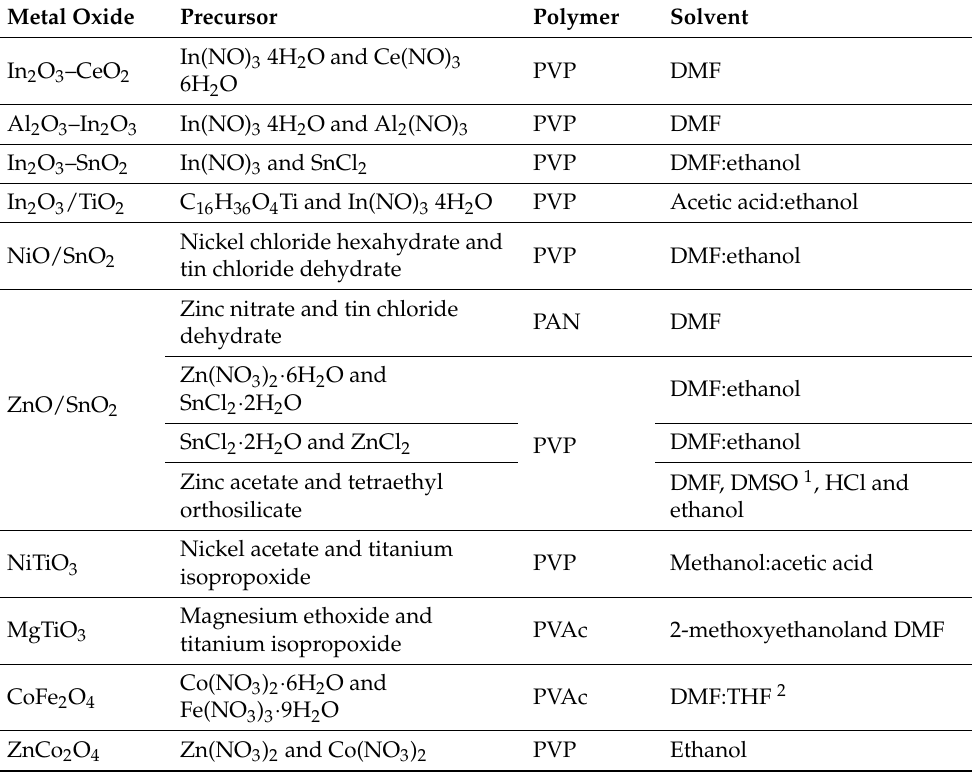
Table 5. Examples of solvents and precursors used to make composite- and multicomponent-based metal oxide